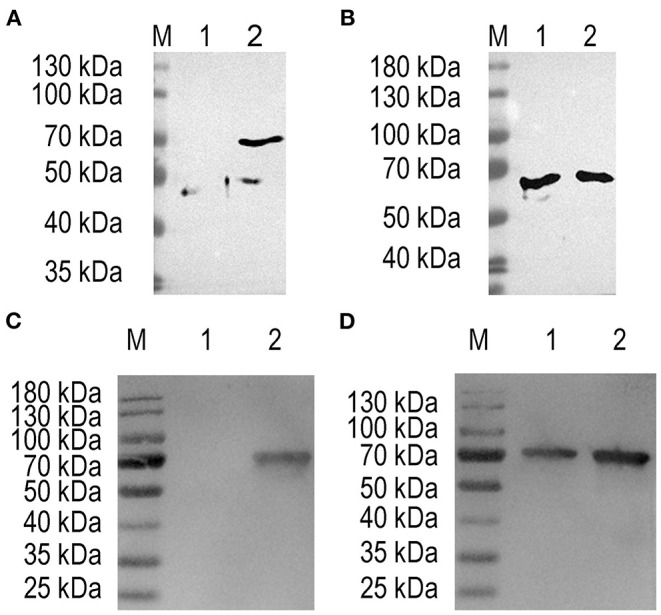
Detection of ΔHexon protein expressed in Lactococcus lactis and Enterococcus faecalis using western blot. Proteins from ΔHexon-expressing L. lactis or ΔHexon-expressing E. faecalis was separated by SDS-PAGE, transferred to nitrocellulose membranes, then reacted with polyclonal antisera against ΔHexon protein. (A) Detection of ΔHexon protein in NZ9000/pTX8048-SP-ΔHexon-CWA. Lane M, protein molecular weight prestained marker (Thermo Scientific™); Lane 1, ΔHexon protein in NZ9000/pTX8048-SP-ΔHexon-CWA without induction by nisin (Sigma-Aldrich); Lane 2, ΔHexon protein (70 kDa) from NZ9000/pTX8048-SP-ΔHexon-CWA induced by 5 ng/mL nisin (Sigma-Aldrich). (B) Detection of ΔHexon protein in MDXEF-1/ΔHexon-CWA. Lane M, Protein molecular weight prestained marker (Thermo Scientific™); Lane 1, ΔHexon protein (70 kDa) in MDXEF-1/ΔHexon-CWA without induction by nisin (Sigma-Aldrich); Lane 2, ΔHexon protein (70 kDa) in MDXEF-1/ΔHexon-CWA induced by 5 ng/mL nisin (Sigma-Aldrich). (C) Detection of ΔHexon protein in NZ9000/DC-ΔHexon-CWA. Lane M, protein molecular weight prestained marker (Thermo Scientific™); Lane 1, ΔHexon protein in MDXEF-1/ΔHexon-CWA protein without induction by nisin (Sigma-Aldrich); Lane 2, ΔHexon protein (72 kDa) in NZ9000/DC-ΔHexon-CWA induced by 5 ng/mL nisin (Sigma-Aldrich). (D) Detection of ΔHexon protein (72 kDa) in MDXEF-1/DC-ΔHexon-CWA without induction by nisin (Sigma-Aldrich). Lane M, protein molecular weight prestained marker (Thermo Scientific™). Lane 1, ΔHexon protein (72 kDa) in MDXEF-1/DC-ΔHexon-CWA without induction by nisin (Sigma-Aldrich). Lane 2, ΔHexon protein (72 kDa) in MDXEF-1/DC-ΔHexon-CWA induced by 5 ng/mL nisin (Sigma-Aldrich).